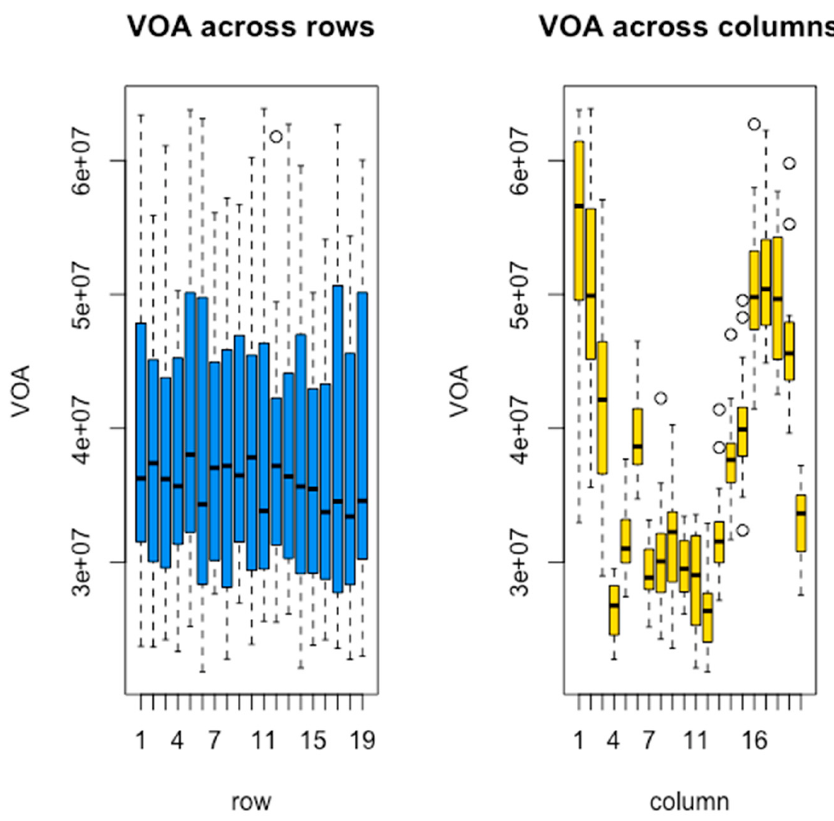
Figure 10. Boxplot showing the distribution of raw values of VOA across fields’ rows and columns.